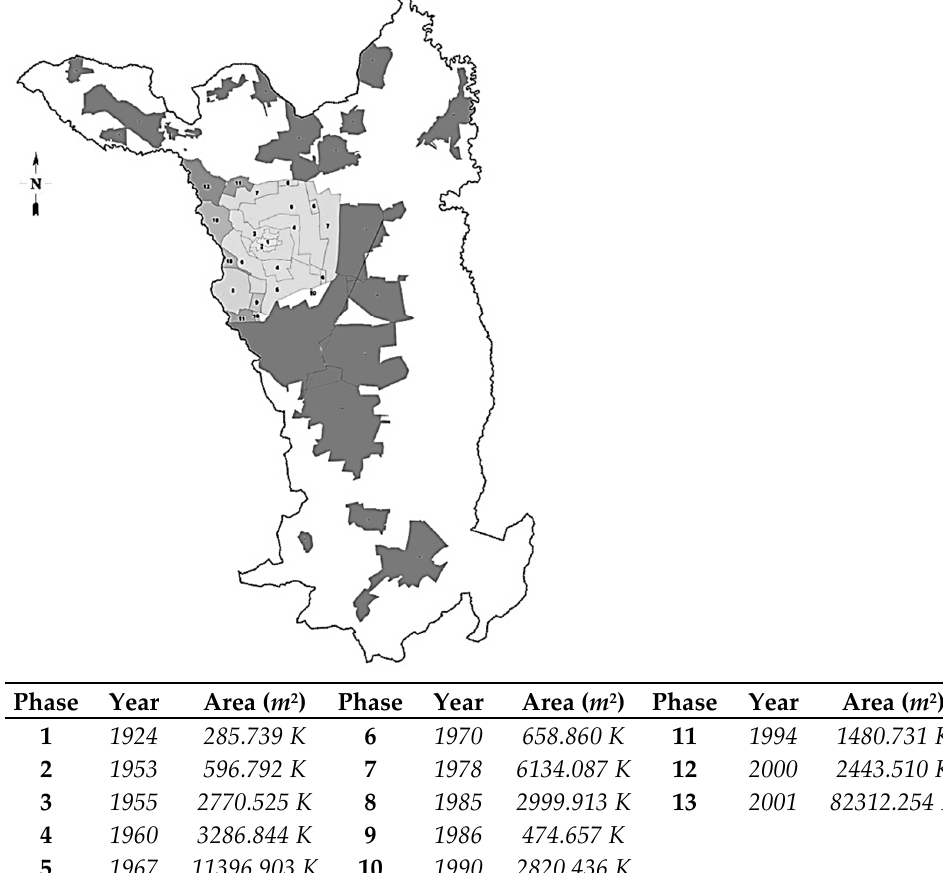
Figure 5. Growth stages of greater Irbid municipality (GIM, 2005) [46]. The growth radius ( ρ ) was collected from the city center (Tal Irbid) to the boundary of each stage at a succession of equal angles ( θ ). This research experimented with a suc- cession of 5 degree angles constituting a sum of 72 wedges, as shown in Figure 6.